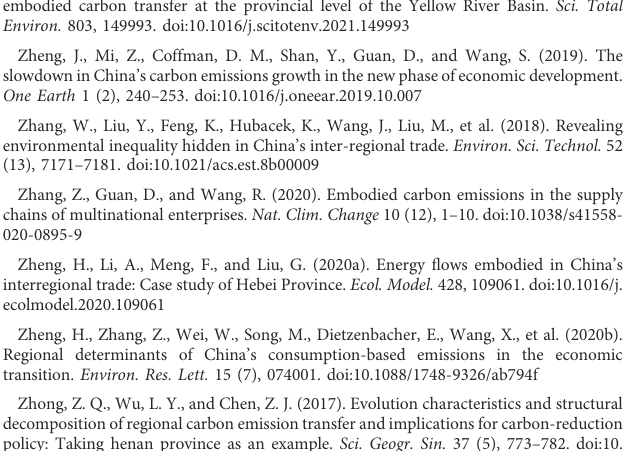
tableduring1997-2007. ActaGeogr.Sin. 69(10),1403 – 1413.doi:10.11821/dlxb201410001 The Carbon Peaking Action Plan (CPAP) (2021). The state council of the people ’ s republic of China. Available at: http://www.gov.cn/zhengce/content/2021-10/26/content_